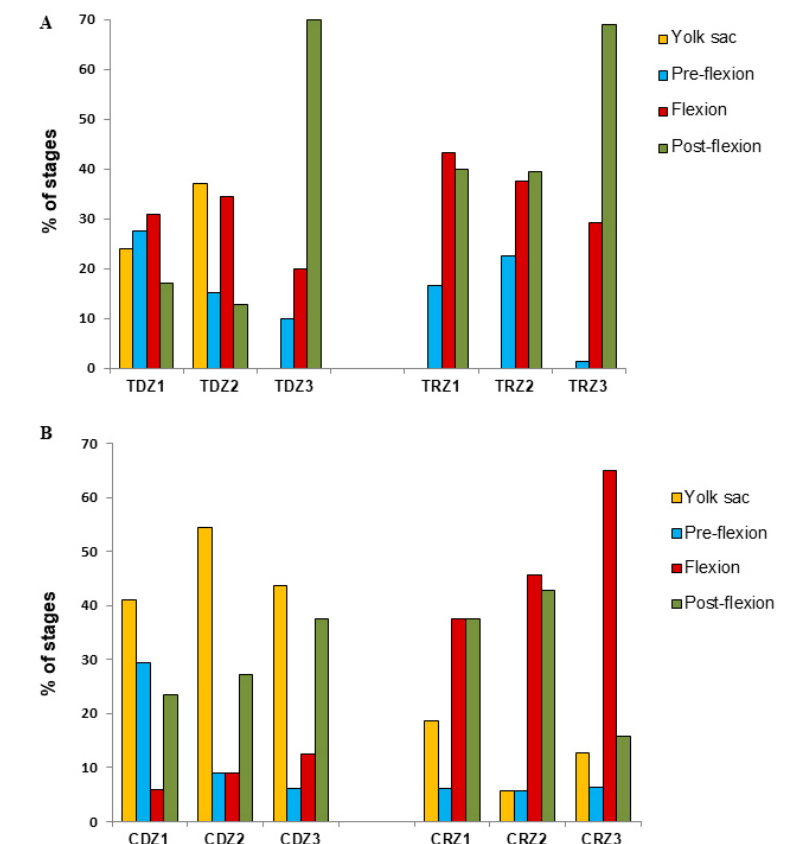
FIGURE 4 | A. Percentage of larval stages of ichthyoplankton in each of zones of Tubarão River estuary (Z1: Lower, Z2: Middle, Z3: Upper) in their periods of dry (TD) and rainy (TR); B. Percentage of ichthyoplankton larval stages in each of Casqueira River estuary zones (Z1: Lower, Z2: Middle, Z3: Upper) during their dry (CD) and rainy (CR) periods.